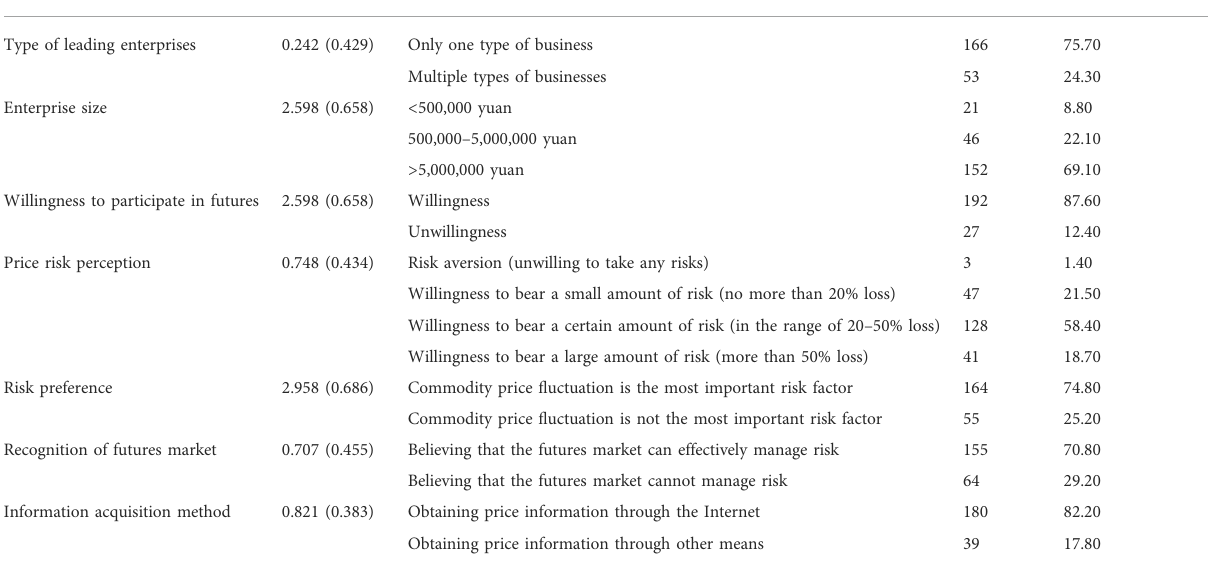
TABLE 2 Summary of descriptive statistics.